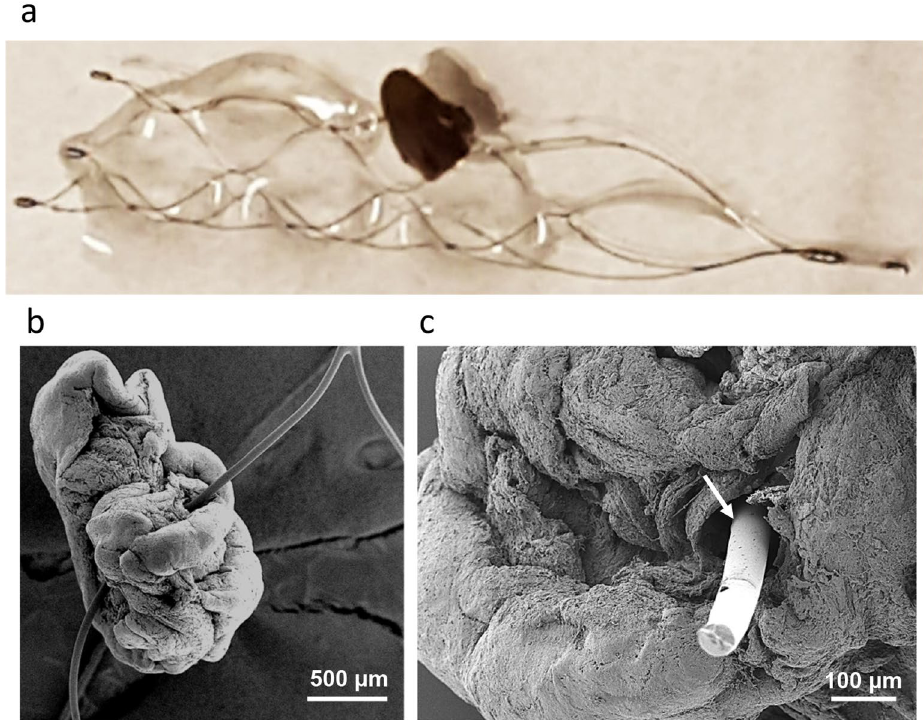
Figure 5. The fibrin rich thrombus integrated in the stent retriever (Case 8 in Table 1). ( a ) Optical micrograph. ( b ) Low magnification SEM view. ( c ) Closer SEM view at the thrombus-stent interface (the stent strut was cut, to allow better viewing). There is no adhesion between the thrombus and the stent strut